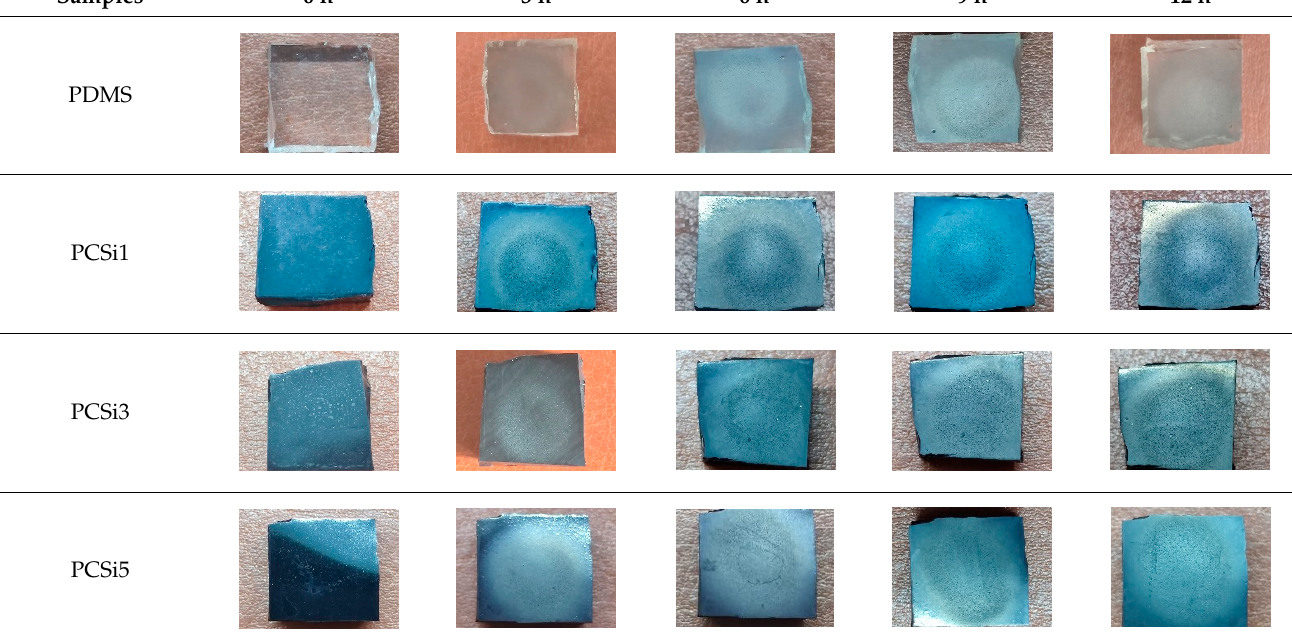
Table 3. Surface images after water erosion.